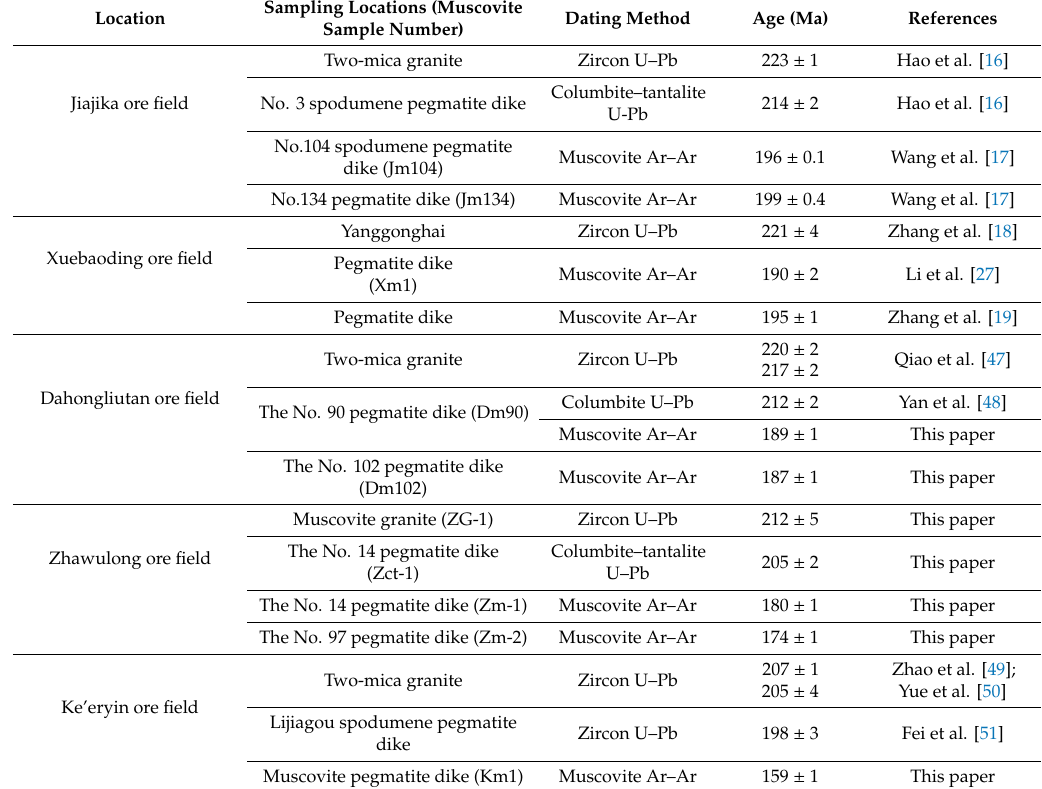
Table 1. Dating results for pegmatite deposits and granitic intrusions in the Songpan–Ganz ê orogenic belt. Numbered locations of samples are provided in Figures